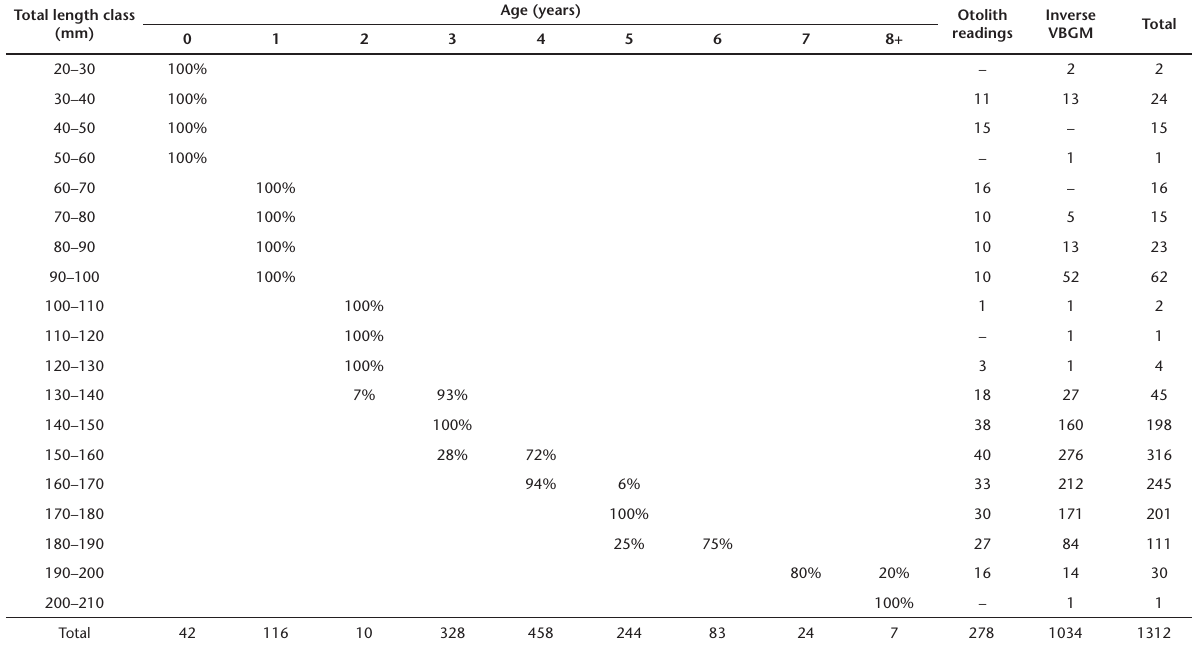
Table 2. Trachurus lathami: age-length key in the Southeastern Brazilian Bight during 2008–2010: percentage (from the total) of individuals by length class and age; number of ages estimated through otolith readings and with the inverse von Bertalanffy Growth Model